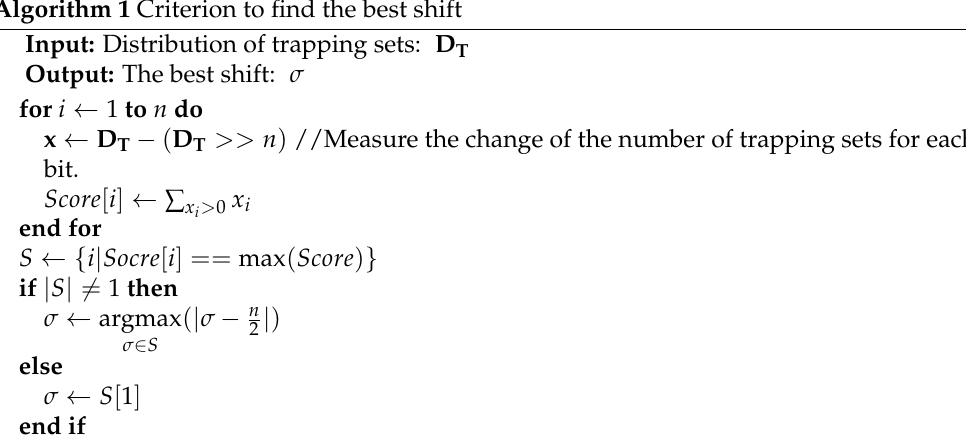
Algorithm 1 Criterion to find the best